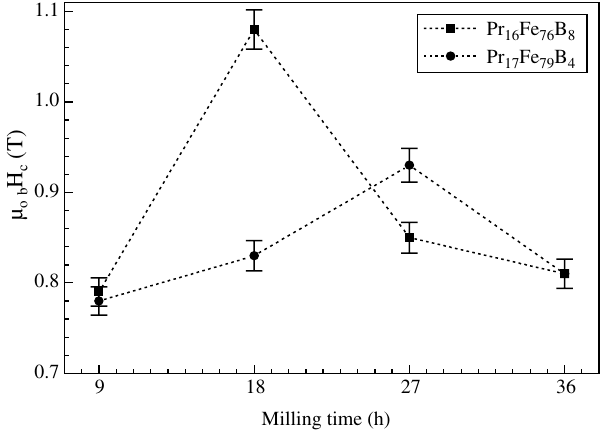
Figure 4. Inductive coercivity of Pr a function of milling time.